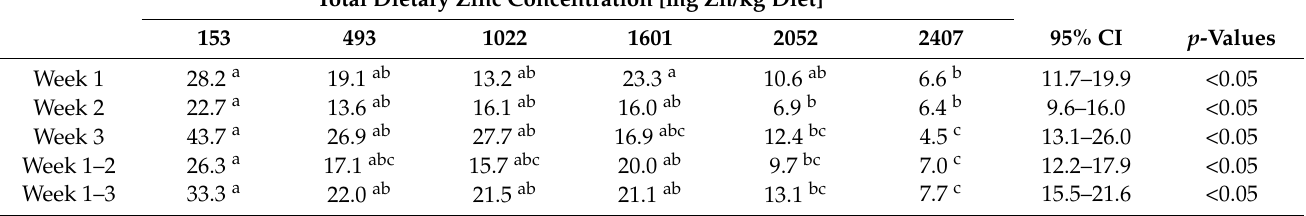
Table 3. Probability (%) of diarrhoea in pigs in different intervals post-weaning dependent on total dietary zinc concentration 1 .